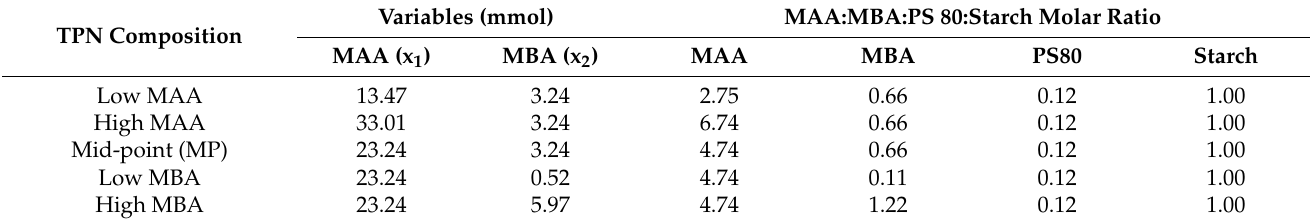
Table 1. Feed levels of the MAA, MBA, PS 80, and starch used during synthesis of TPNs with various